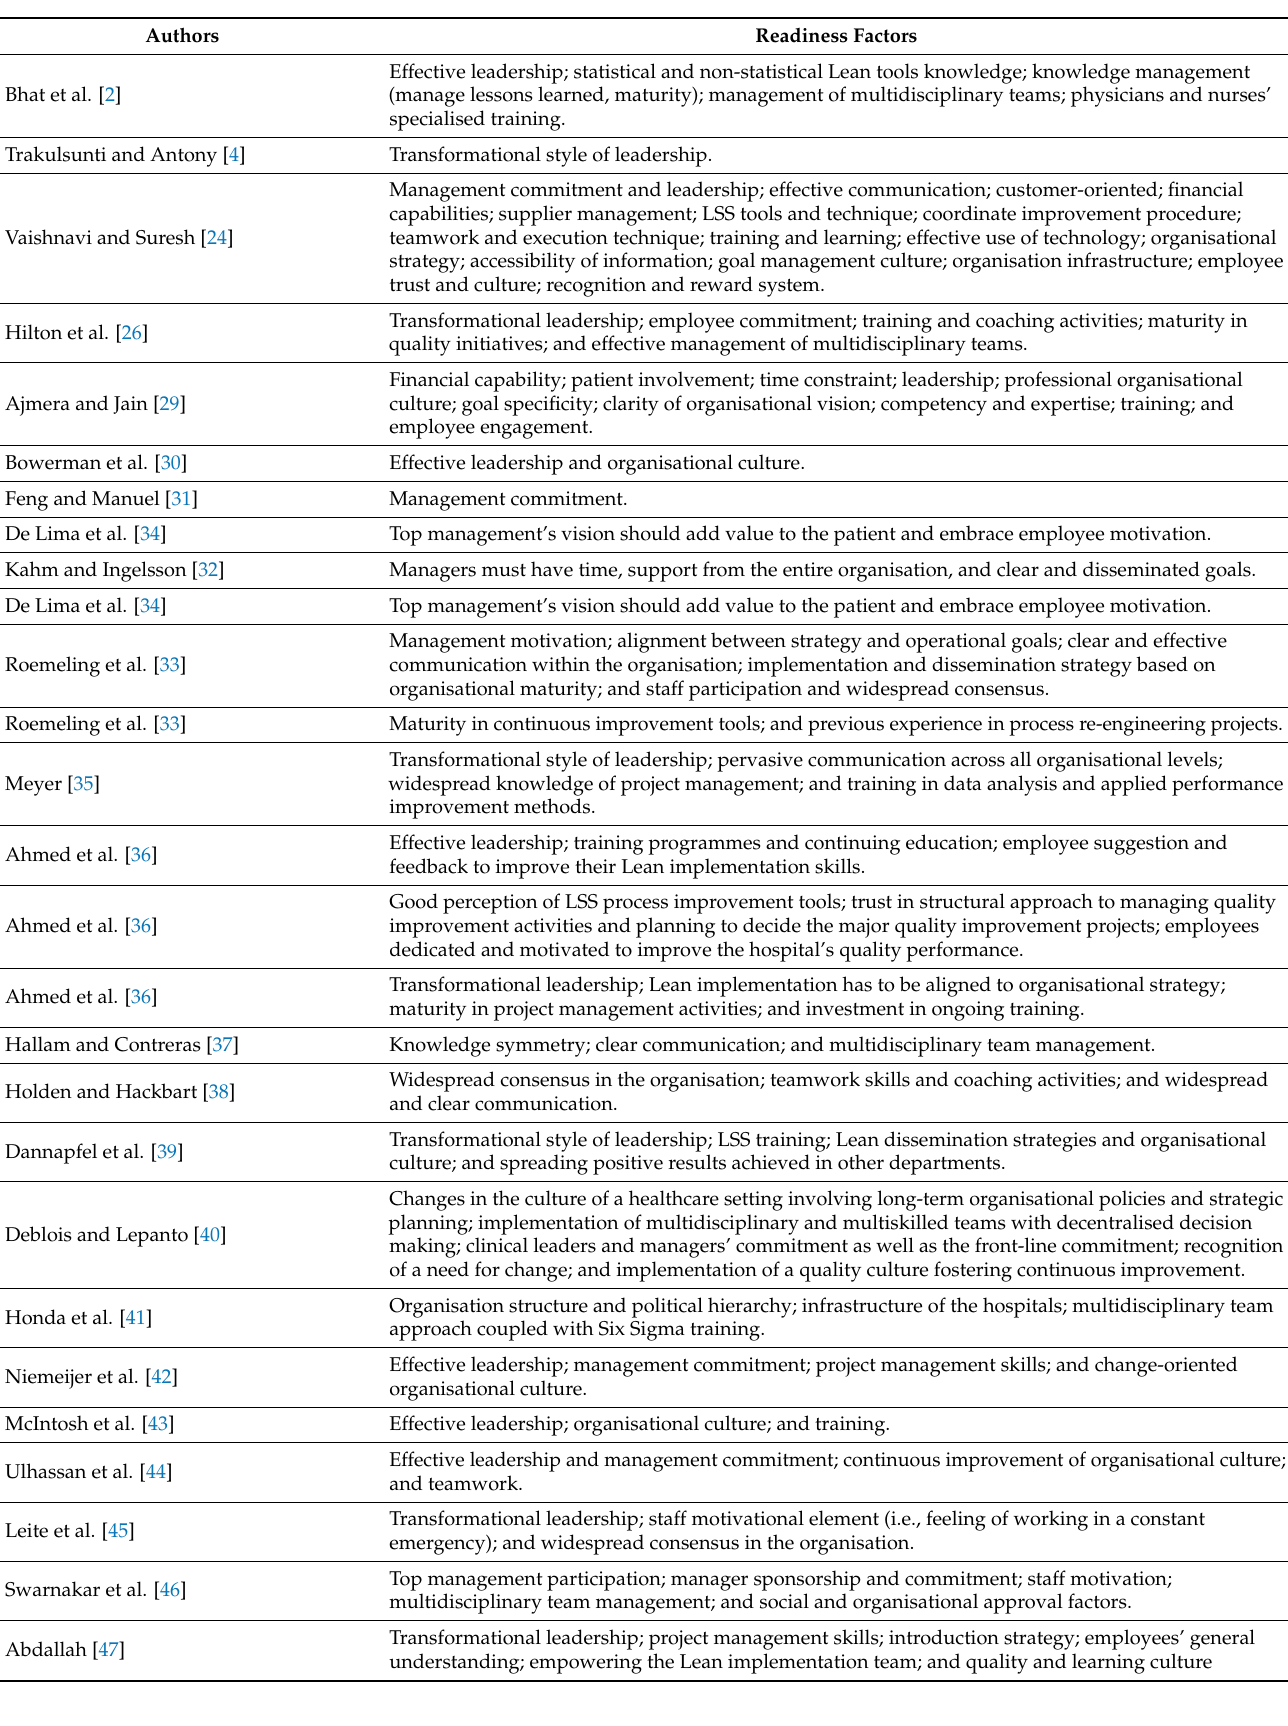
Table 1. Readiness factors for LSS in